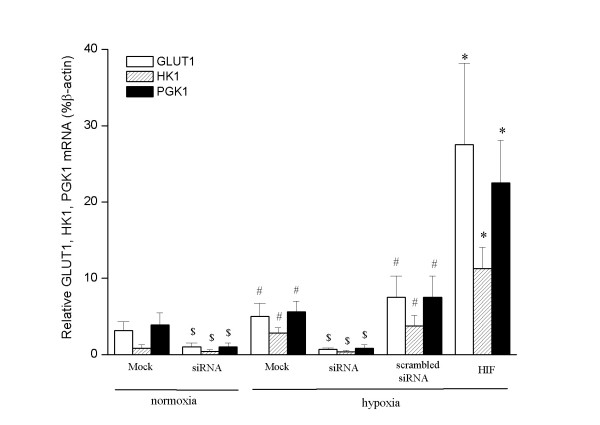
siRNA-mediated knock-down of HIF-1α expression leads to the suppression of three key glycolysis genes. Expression of three key genes in the glycosis pathway, GLUT1, HK1, and PGK1 was monitored by real-time RT-PCR. Cells were transfected with HIF-1α siRNA EGFP-pSUPER vector, scrambled HIF-1α control siRNA, or an expression plasmid encoding HIF-1α. After 20 h, transfected cells were exposed to hypoxia for 24 h (n = 5 in each group). $, P < 0.05 compared to normoxic control; #, P < 0.05 compared to normoxic and hypoxic HIF-1α siRNA; *, P < 0.05 compared to hypoxic mock-transfected and scrambled HIF-1α control siRNA transfection. siRNA: HIF-1α siRNA vector transfected, Mock: mock transfected, HIF: HIF-1α expression plasmid transfected.